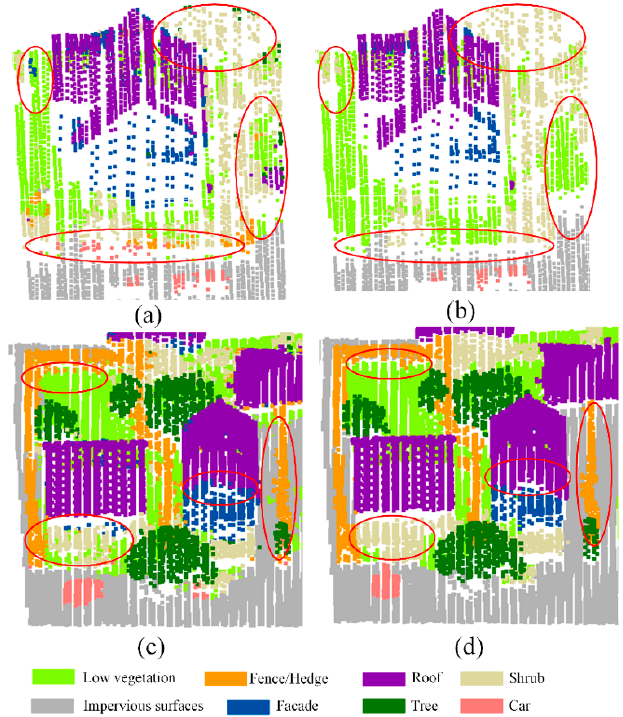
Figure 11. The classification results before and after graph-cuts optimization on ISPRS benchmark dataset: ( a ) the classification results before graph-cuts optimization of area1, ( b ) the classification results after graph-cuts optimization of area1, ( c ) the classification results before graph-cuts optimization of area2, ( d ) the classification results after graph-cuts optimization of area2.